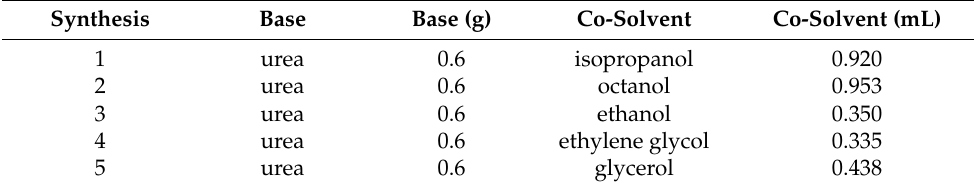
Table 2. WMS synthesis specifications for different